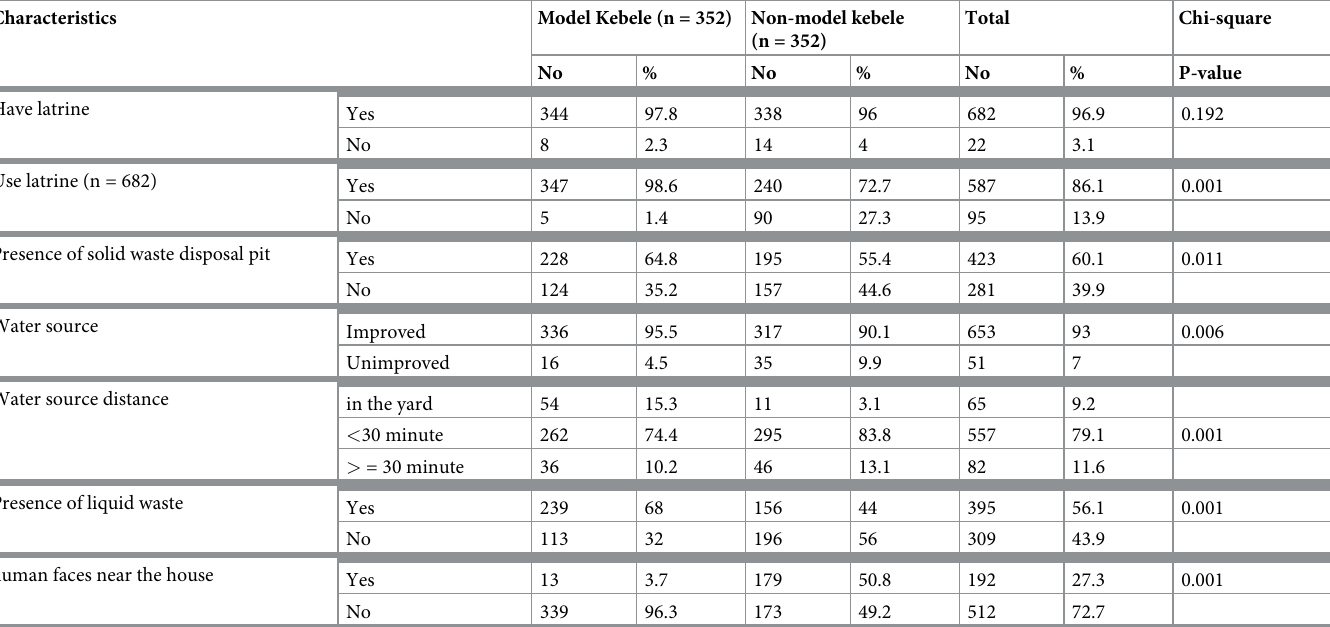
Table 2. The households’ environmental and housing conditions in the model and non-model kebeles in Dangila district, northwest Ethiopia, 2019 (n = 704). Characteristics